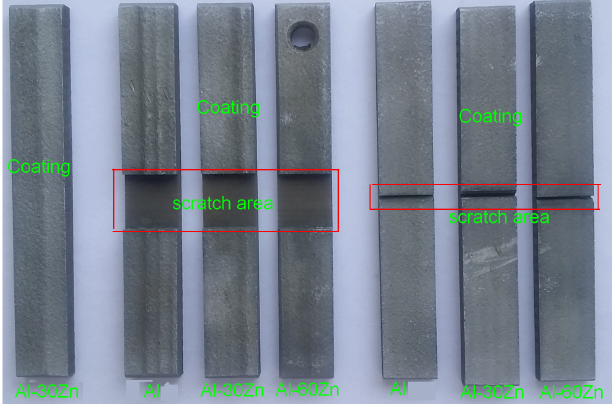
Figure 7. Photograph of cold ‐ sprayed AlZn coatings with different scratch areas.